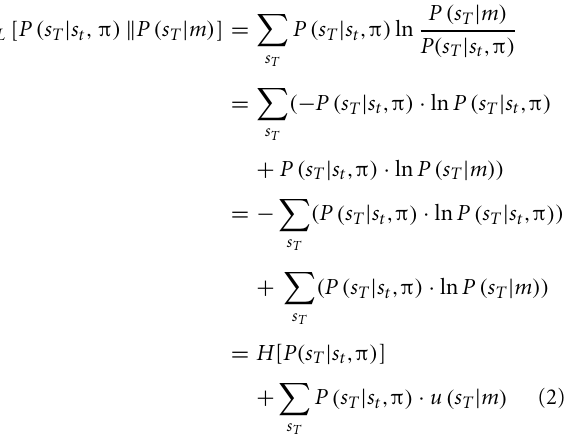
policy that maximizes expected utility corresponds to